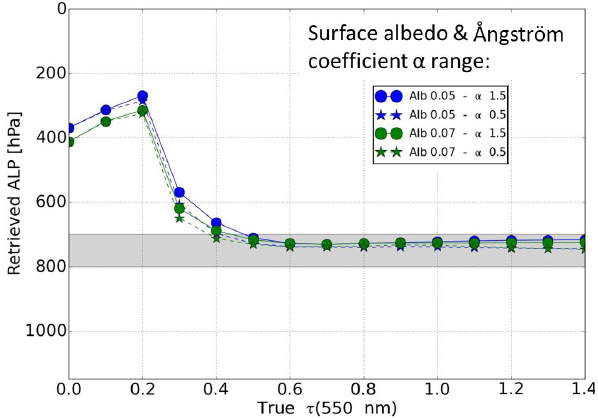
Figure 13. Same as Fig. 10 but with one unique aerosol ω 0 value ( = 0 . 95) and two aerosol α (1.5 and 0.5) in the reference aerosol scenarios. ALP retrievals are estimated from the NN algorithm trained with aerosol ω 0 = 0 . 95 similarly to the desert dust case in Sect.